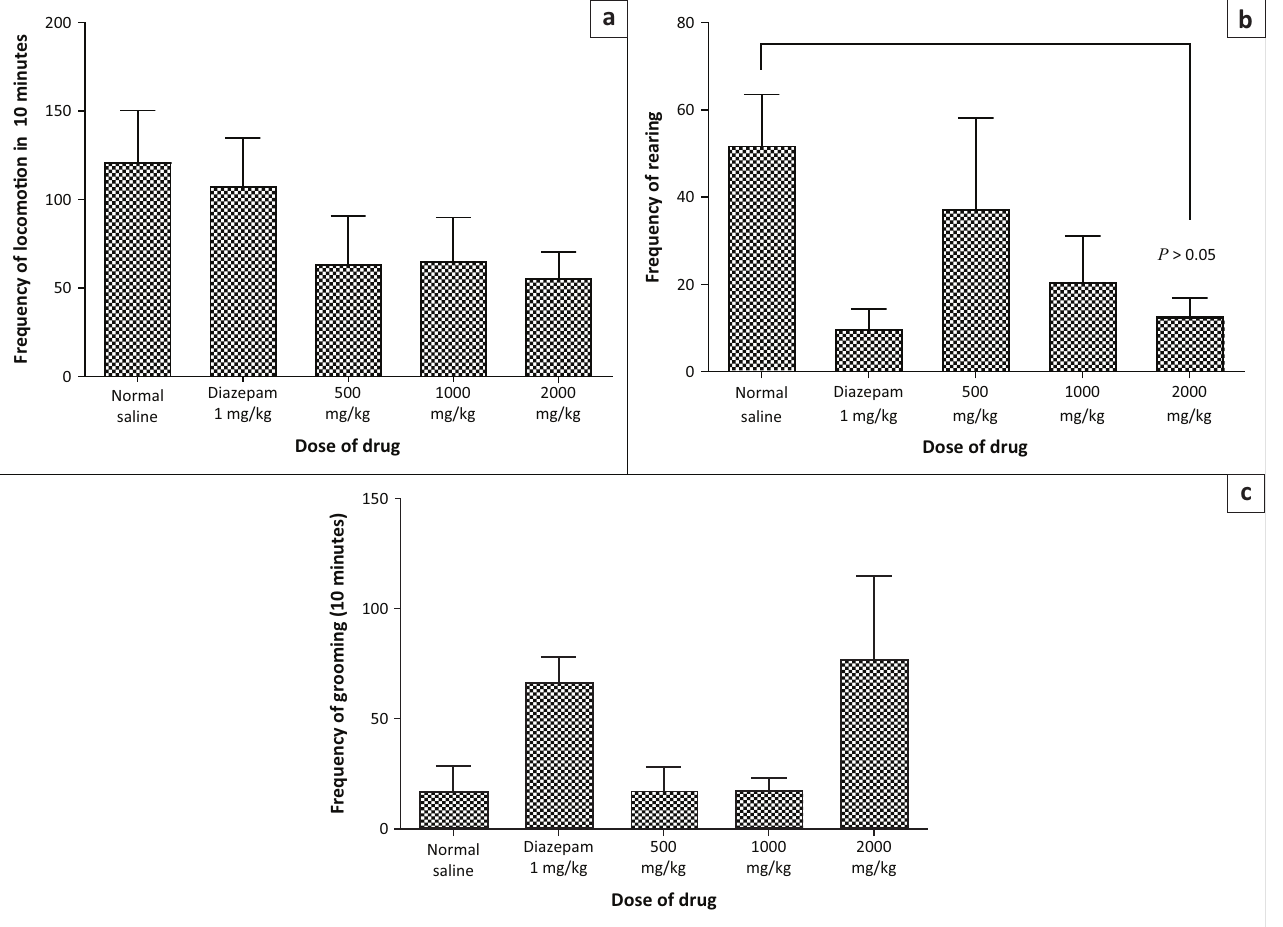
FIGURE 2: Frequency of grooming in mice administered 500, 1000 and 2000 mg/kg of ethanolic leaf extract of Combretum micranthum , 1 mg/kg diazepam and normal saline in mice. Data are expressed as mean ± standard error of mean (S.E.M.) and analysed using one-way analysis of variance (ANOVA) with p < 0.05 considered as